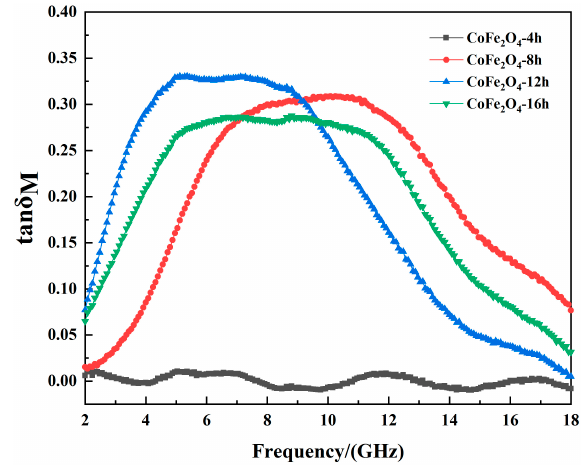
Figure 7. The magnetic loss factor of cobalt ferrite.